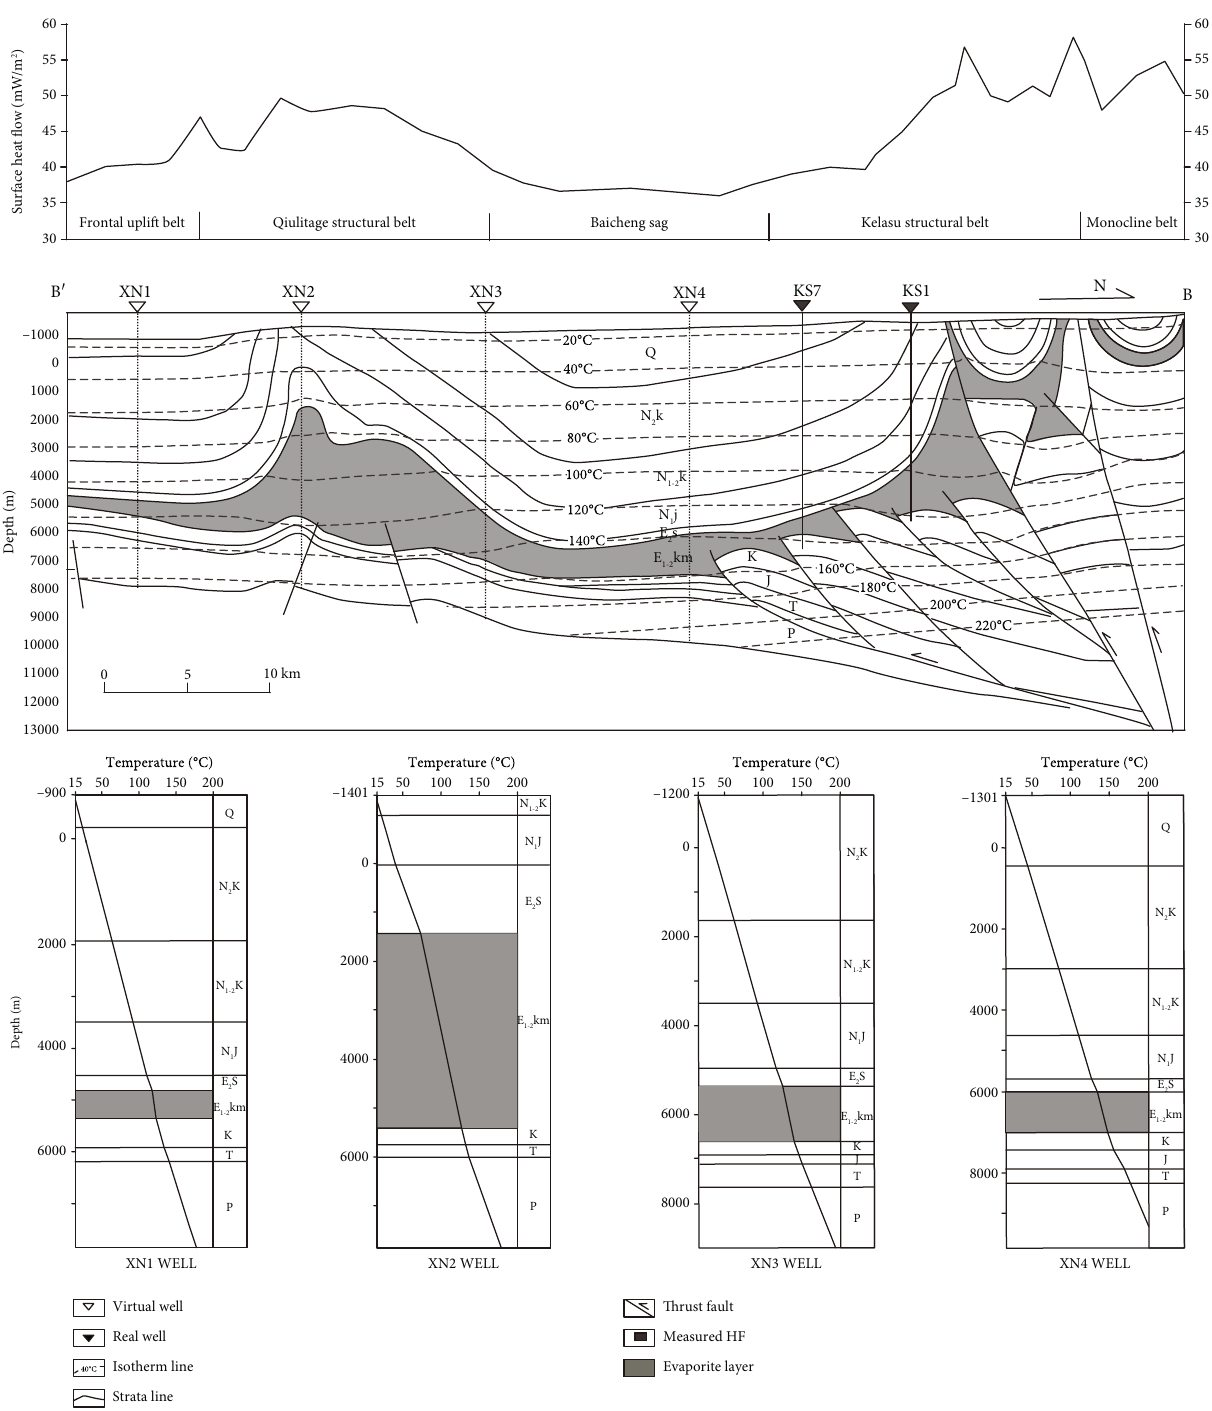
Figure 11: Temperature fi eld in section B-B ′ and the in fl uence of evaporate rock on the temperature and HF